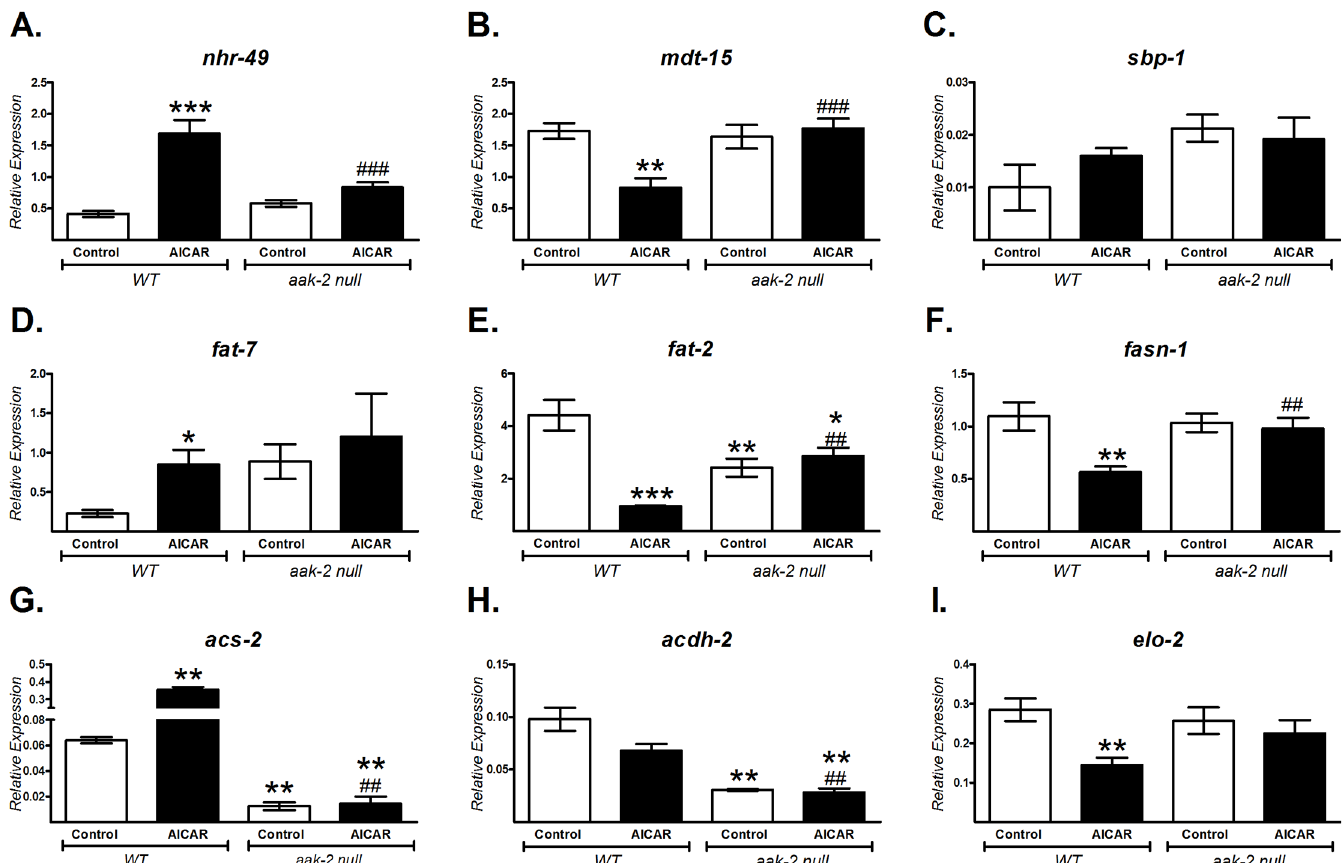
Fig 4. AAK activation-dependent changes of selected transcripts involved in energy metabolism regulation in C . elegans . Gene expression analysis was performed using qRT-PCR on wild-type N2 ( WT ) and aak-2 / ok524 nematodes grown until adults and exposed to 1 mM AICAR for 12 h. A) nhr-49 , B) mdt-15 , C) sbp-1 , D) fat-7 , E) fat-2 , F) fasn-1 , G) acs-2 , H) acdh-2 and I) elo-2 . The relative expression of each gene was normalized to endogenous 18S rRNA gene expression. Data shown are the mean ± SEM of three independent experiments, * p < 0.05, ** p < 0.01, *** p < 0.001 vs. WT control and ## p < 0.01, ### p < 0.001 vs. WT AICAR, one-way ANOVA with Bonferroni's post hoc test using GraphPad Prism.